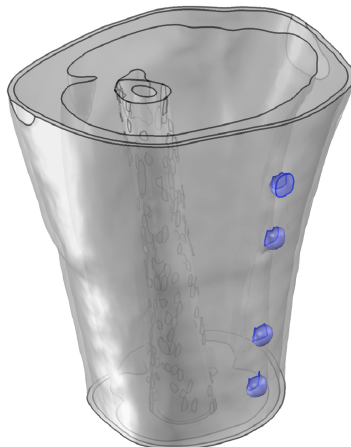
Fig. 20: 3D view of the model with electrodes selected. It is now time to save your file. A model file containing the model is available in the supplementary data. It is named tutorial-model.mph .